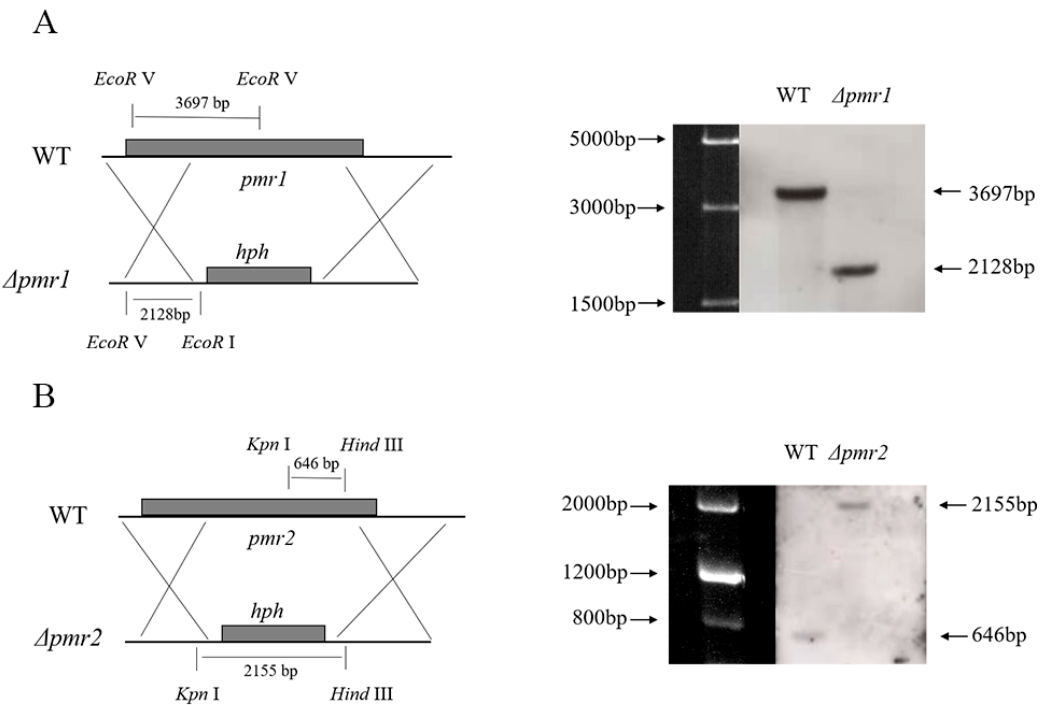
Figure 2. Confirmation of the disruption of pmr1 and pmr2. ( A ) Southern blotting for verification of the pmr1 deletion. The left panel shows the knock-out strategy for pmr1 via homologous recombination and the restriction enzyme sites used in Southern blot are indicated. Genomic DNAs from NK17 and ∆ pmr1 were digested with EcoR I and EcoR V. One band of 2128 bp on the membrane was obtained for ∆ pmr1 , and one band of 3697 bp was found for WT. ( B ) Southern blotting for verification of the deletion of pmr2 . Genomic DNAs from NK17 and ∆ pmr2 were digested with Kpn I and Hind III. One band of 2155 bp on the membrane was obtained for ∆ pmr2 , and one band of 642 bp was found in WT.